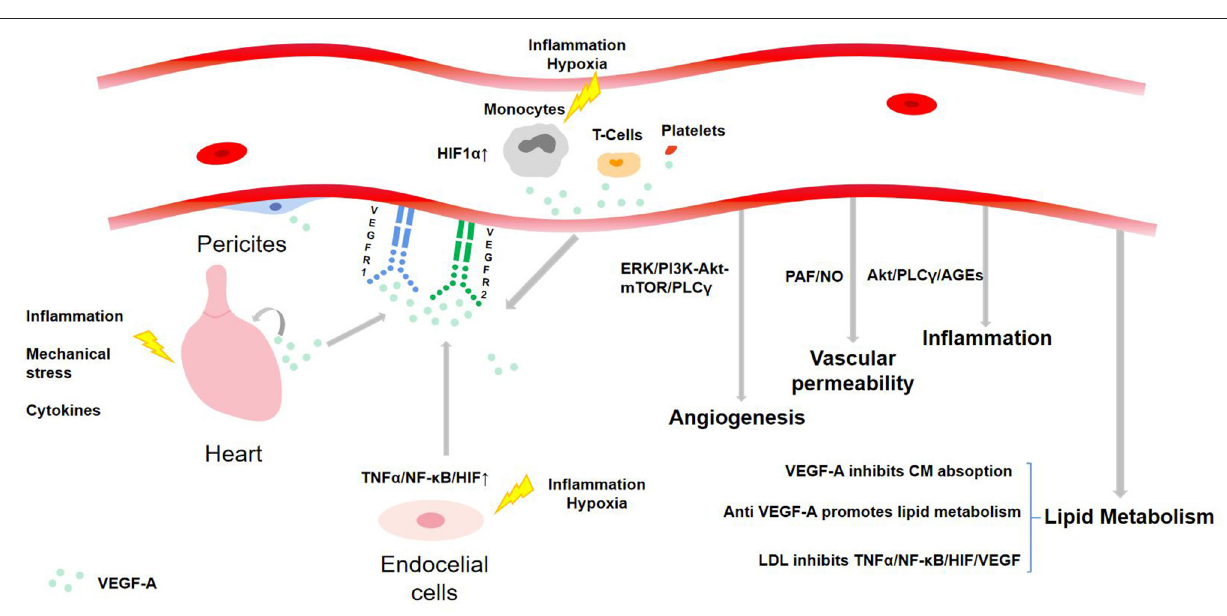
FIGURE 3 | The source and regulation mechanism of VEGF-A with